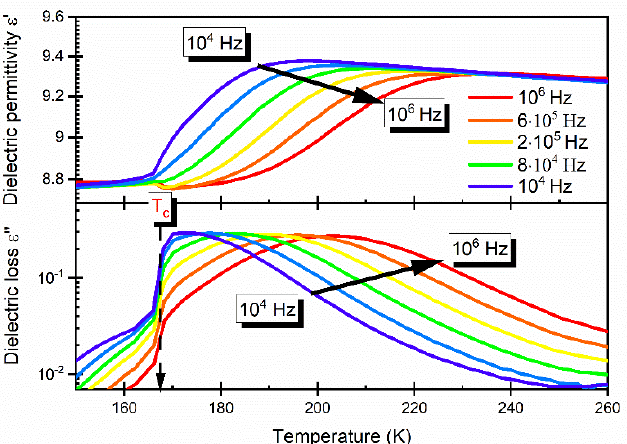
Figure 5. A comparison of the temperature dependencies of IR bands, corresponding to ν NH 2 ( a ), δ NH 2 ( b ), and ρ NH 2 ( c , d ) for DMAZnD (D, blue) and DMAZnF (H, red) [35]; the lines are guides for eyes, fwhm, full − width at half maximum.